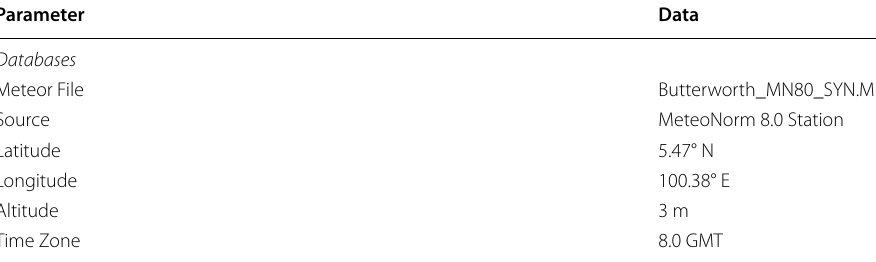
Table 3 PVsyst meteorological dataset for location in Malaysia